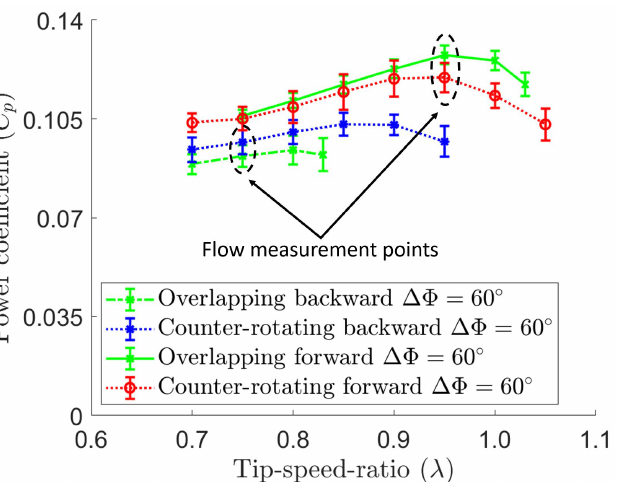
Figure 11. The power curves of counter-rotating and overlapping configurations at ∆Φ = 60 ◦ , which was adapted from [10], with the flow measurement points